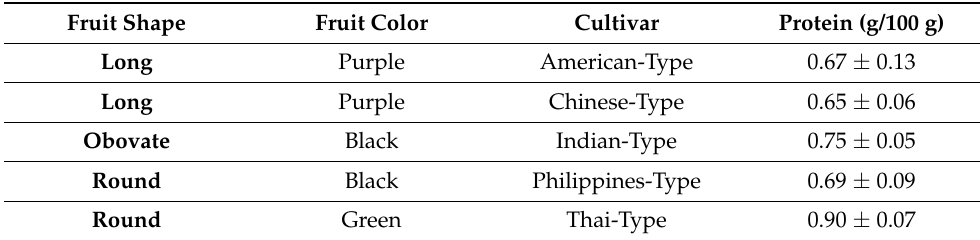
Table 2. Variations in protein content (g/100 g) in different eggplant cultivars on a fresh weight basis, adapted from Guillermo et al.